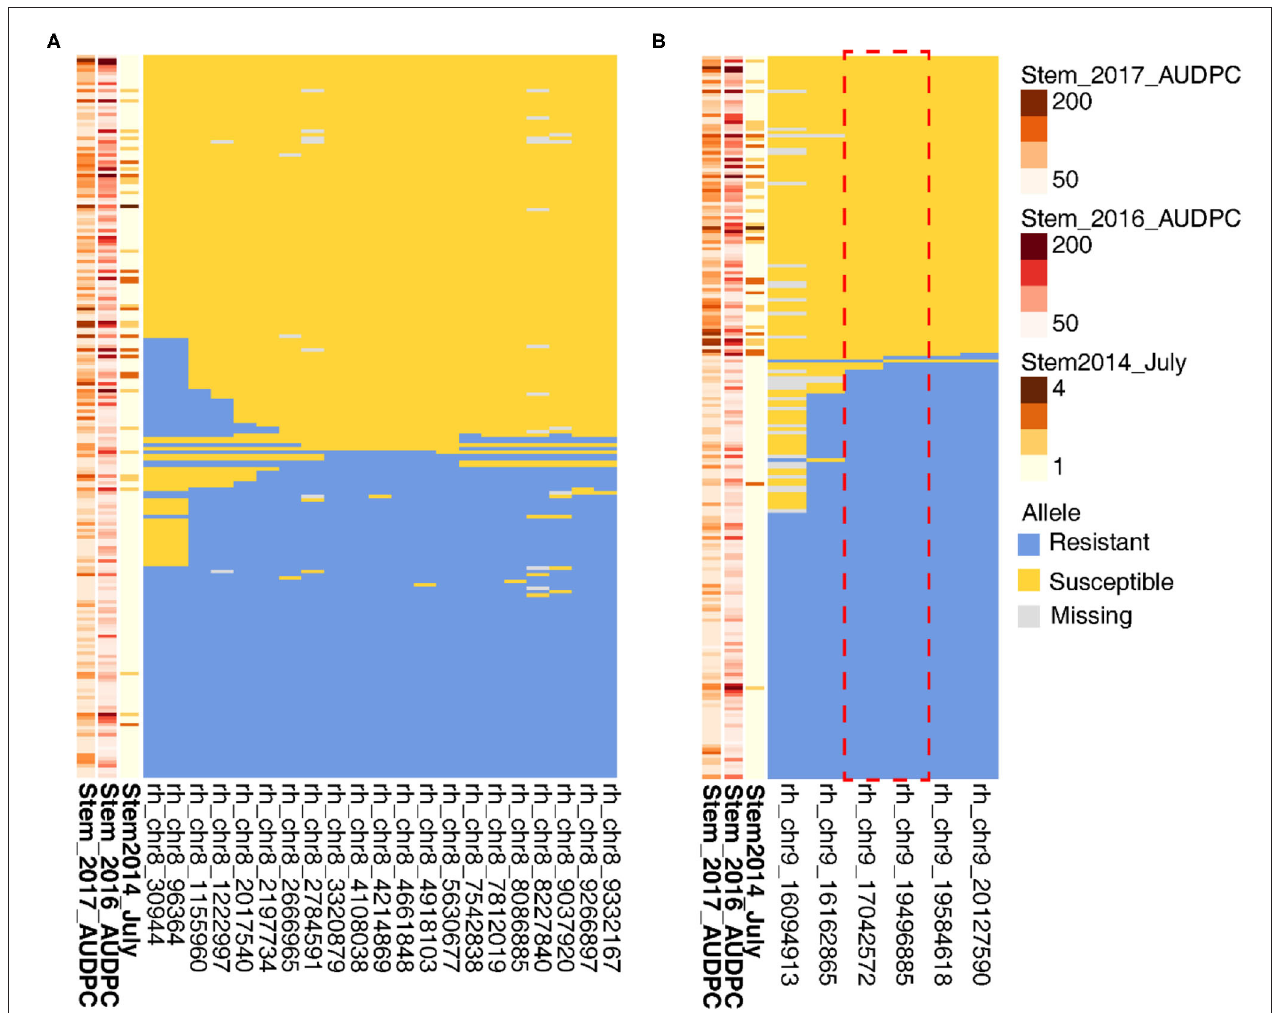
FIGURE 7 | Recombinations within stem resistance QTL define the loci on Chr 9 but not on Chr 8. On the left of each panel, higher disease severity is indicated by the darker brown for (A) Chr 8 and (B) Chr 9. Each row represents a different vine, and columns represent a phenotype or rhAmpSeq marker.